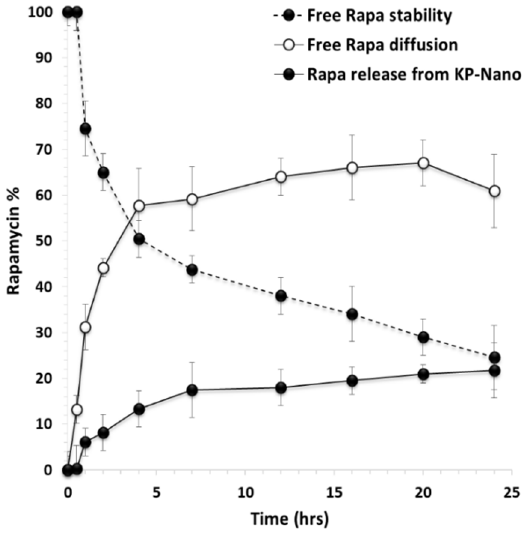
Figure 3. Free Rapa stability (- - • - -), free Rapa diffusion (-o-) and Rapa release profile (- • -) from KP-Nano across the dialysis membrane in DPBS/fetal bovine serum (FBS) (pH 7.4). Data represent mean ± S.D., ( n = 3).